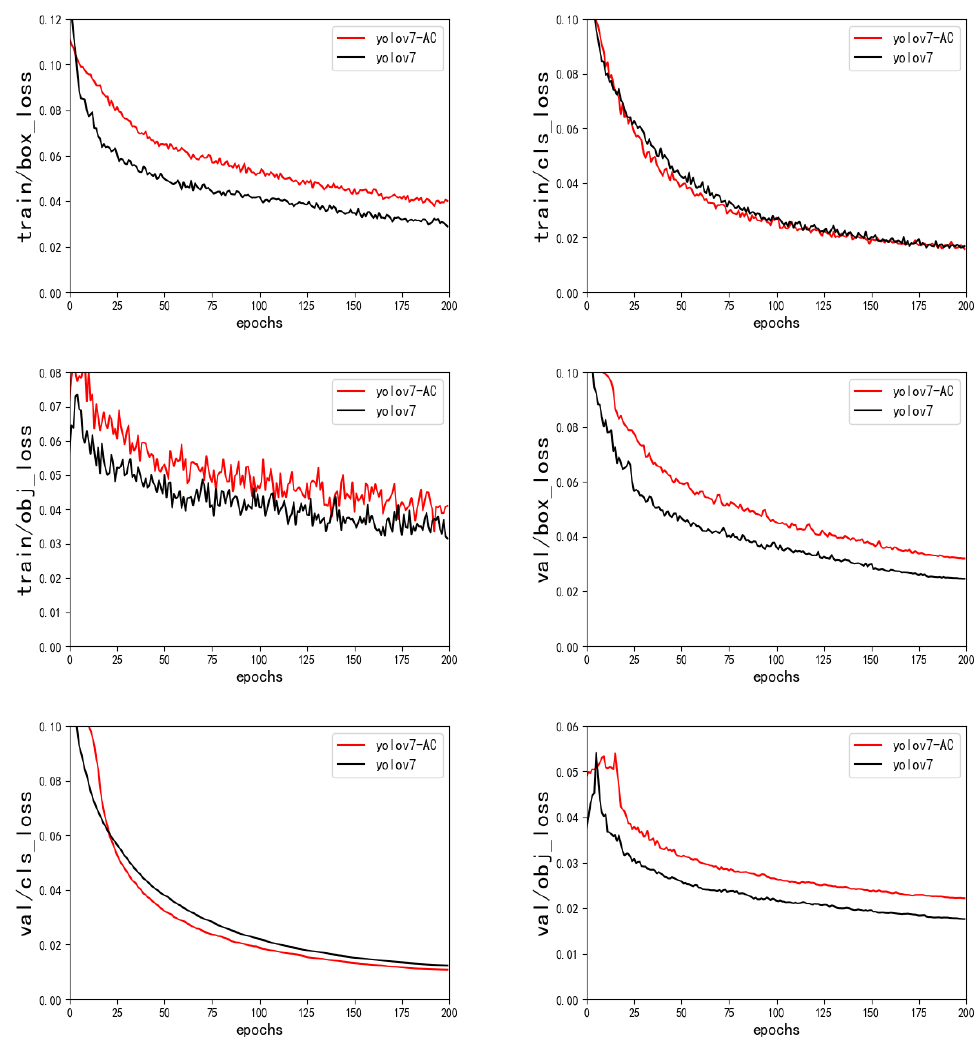
Figure 11. Results of the YOLOv7 ACmix ablation experiment. Table 4. YOLOv7-ACmix network performance.